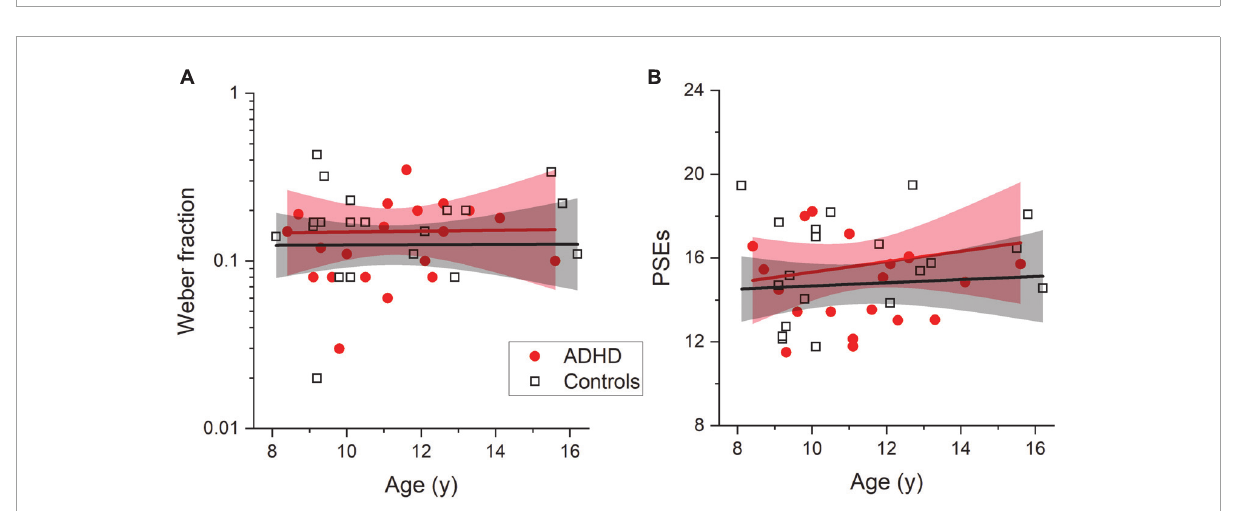
FIGURE5 Developmental trajectories. Numerosity discrimination thresholds (Wf, A ) and point of subjective equality (PSEs, B ) as a function of chronological age for both controls (black squares) and participants with ADHD (red circles). Lines report best linear fitting with associated confidence bands